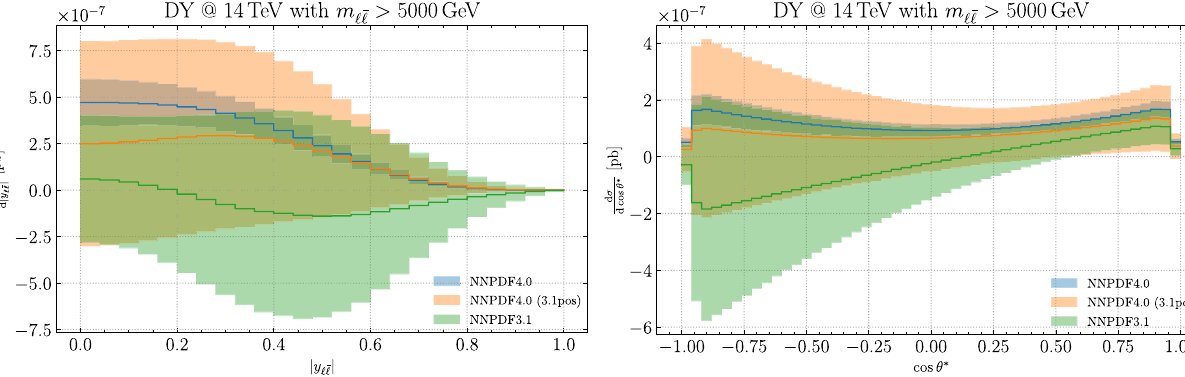
Fig. 24 Same as Figs. 17 and 19 for the absolute dilepton rapidity | y (cid:2) ¯ (cid:2) | (left) and the cos θ ∗ (right) distributions for dilepton invariant masses of m (cid:2) ¯ (cid:2) ≥ 5 TeV comparing NNPDF4.0, NNPDF4.0(3.1pos), and